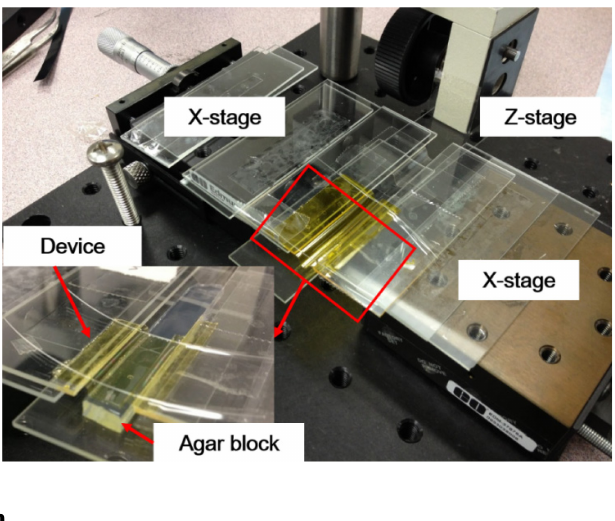
Figure 4. Experimental setup for bending angle measurements with the zoomed view of the deployable device in contact with an agar